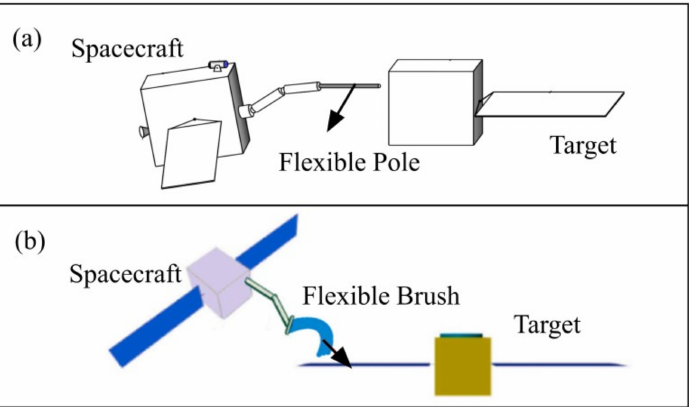
Figure 4. Pre-processing of tumbling target with parts: ( a ) flexible rod [63]; ( b ) flexible brush [66].